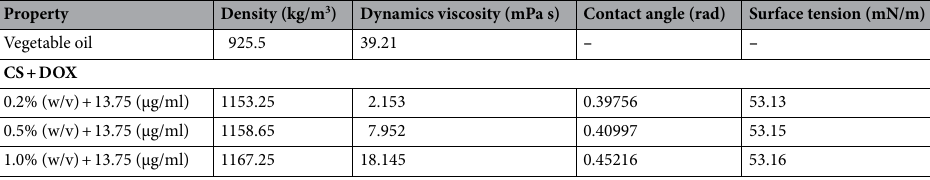
Table 2. The components properties utilized in this